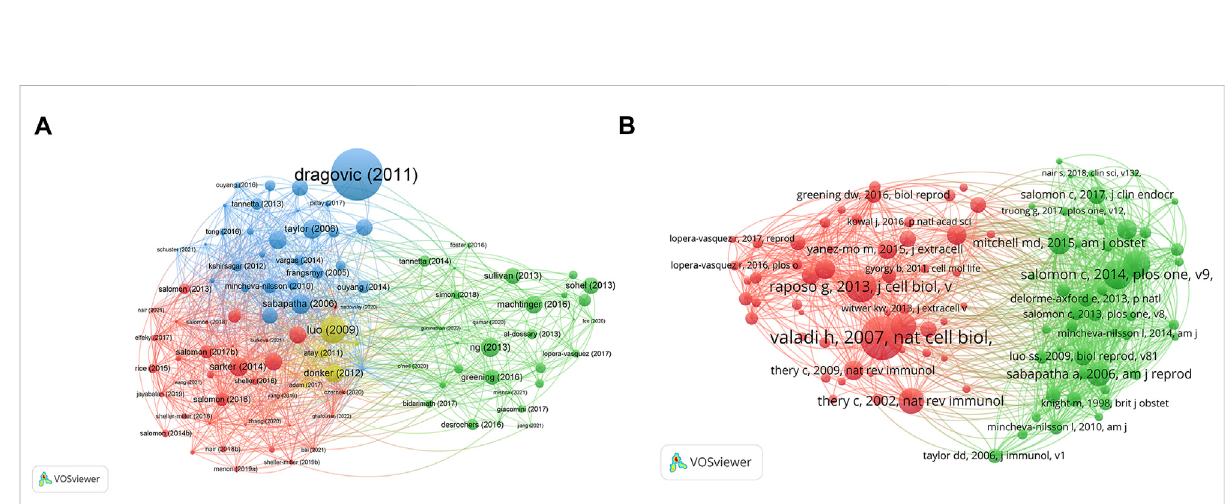
FIGURE 6 The distribution ofcitations pertaining to researchon exosomes inreproduction. (A) Citation analysis ofdocuments. (B) co-citationsanalysisof